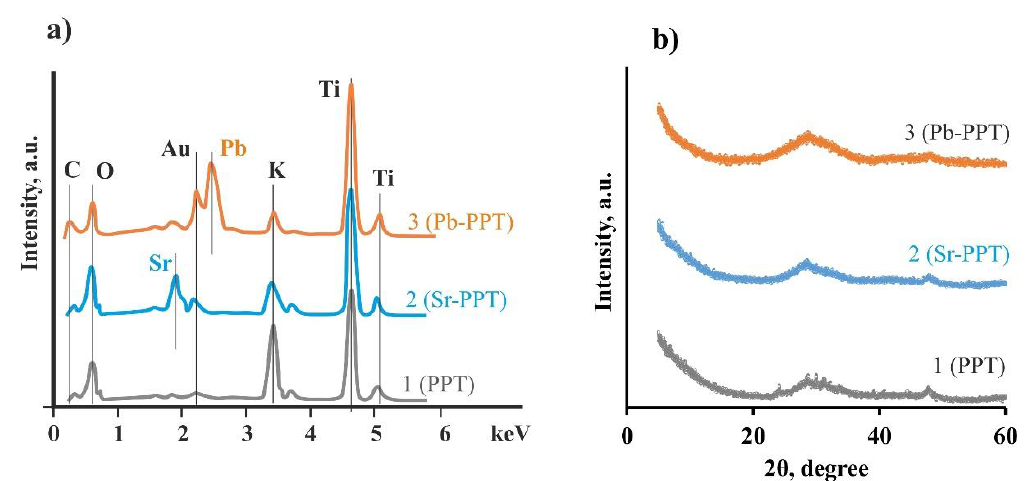
Figure 2. Chemical composition data (energy-dispersive X-ray spectroscopy (EDX)) ( a ) and X-ray ( b ) of synthesized PPT and exposed sorbents (Sr-PPT and Pb-PPT).